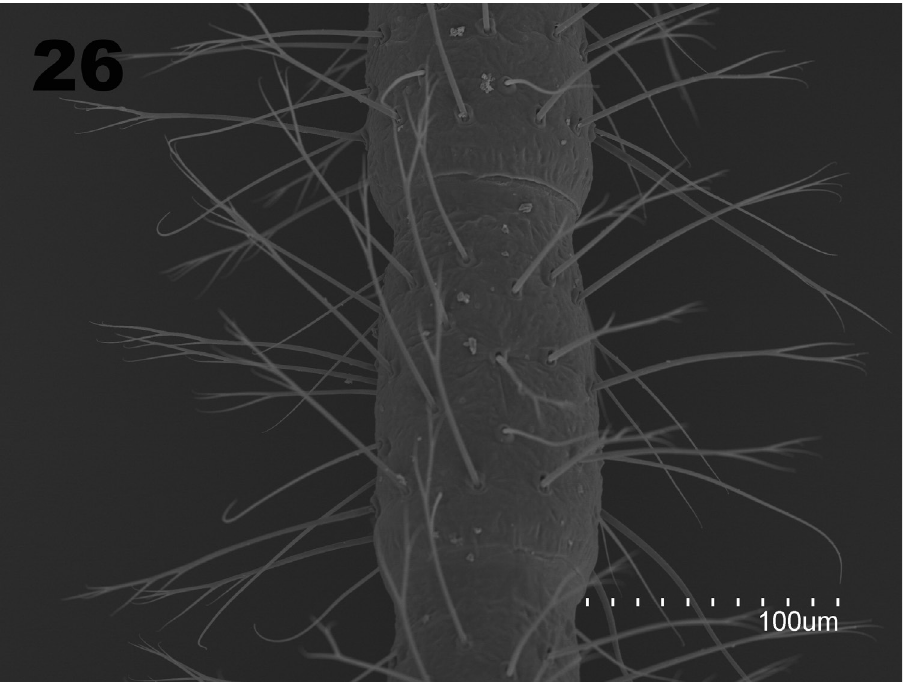
Figure 26. Haplocampa wagnelli Sendra, sp. n. First primary cercal article, lateral side.